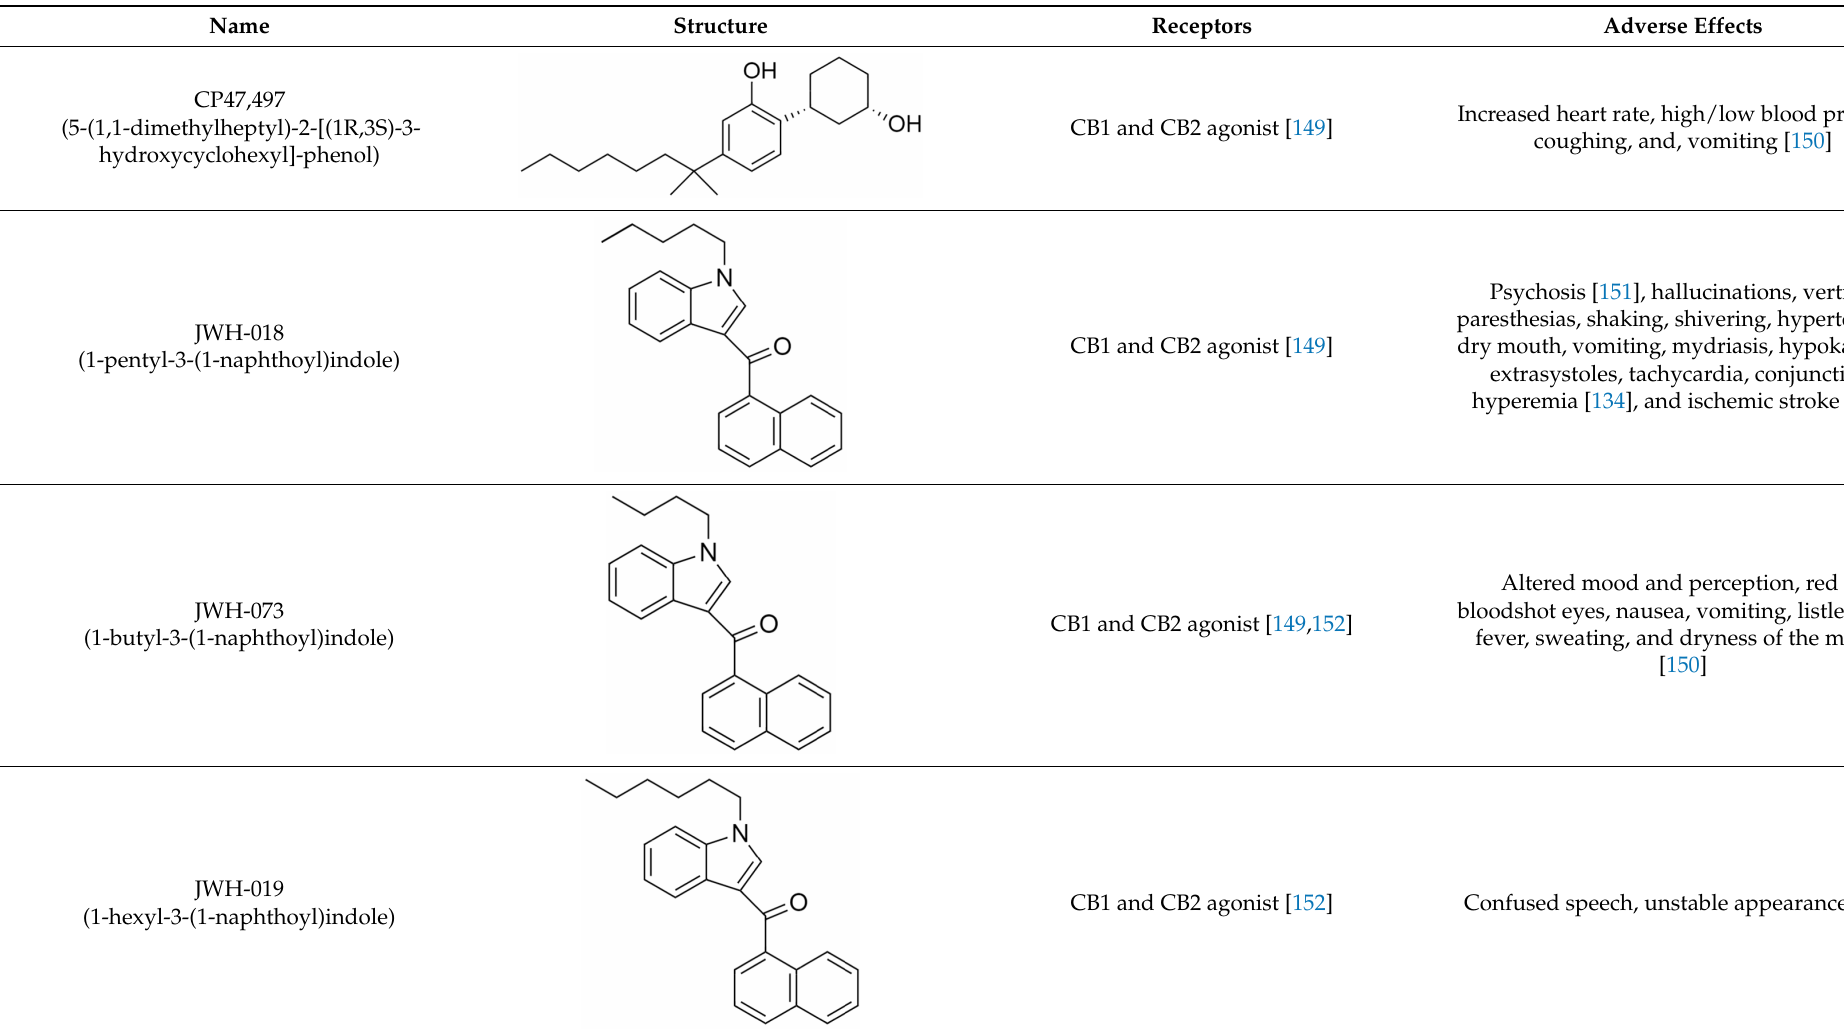
Table 2. List of schedule 1 synthetic cannabinoids with their structures and adverse